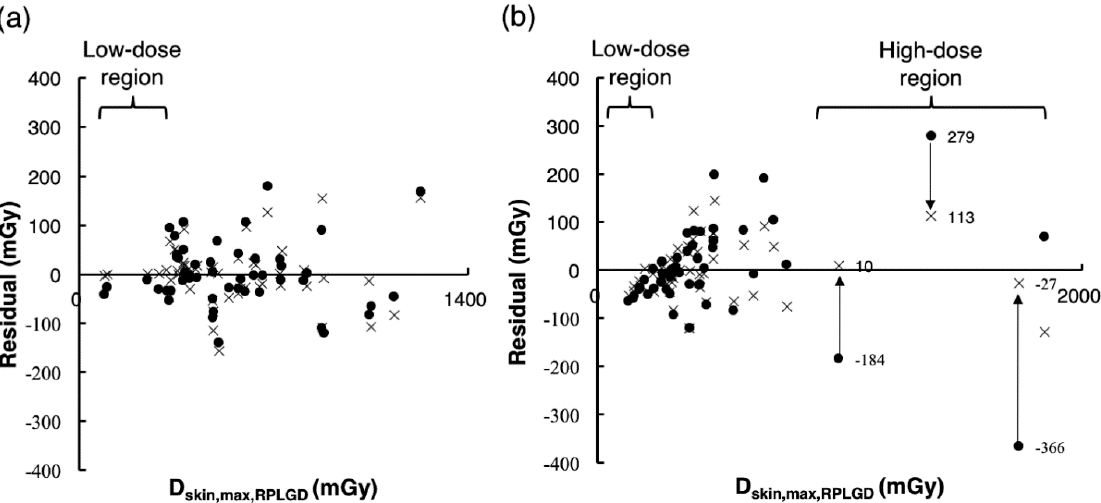
Figure 6. Residue plots of directly estimated D skin,max RPLGD and indirectly estimated D skin,max,Ka . The residues of D skin,max RPLGD − D skin,max,Ka are plotted for ( a ) the test data set ( n = 50) and ( b ) the validation data set ( n = 50). The circles ● indicate the differences between the D skin,max,Ka estimated using the CF Ka,constant (Estimation Model 1) and D skin,max RPLGD , and the crosses × indicate the differences between D skin,max,Ka estimated using the CF Ka,function (Estimation Model 2) and D skin,max RPLGD . In the low-dose region of the test data set and the low-dose and high-dose regions of the validation data set, the residues with negative values when estimated using Estimation Model 1 were close to zero when Estimation Model 2 was used, highlighting the corrective effect of CF Ka,function .